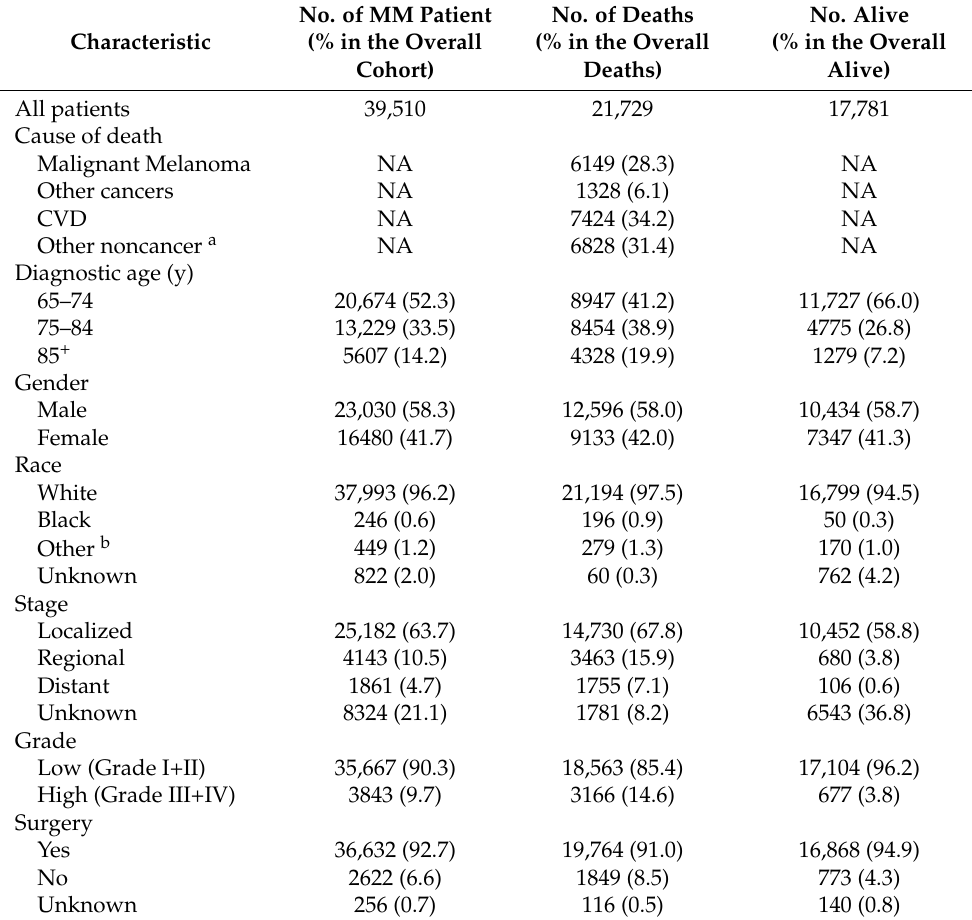
Table 1. Characteristics of the study population.